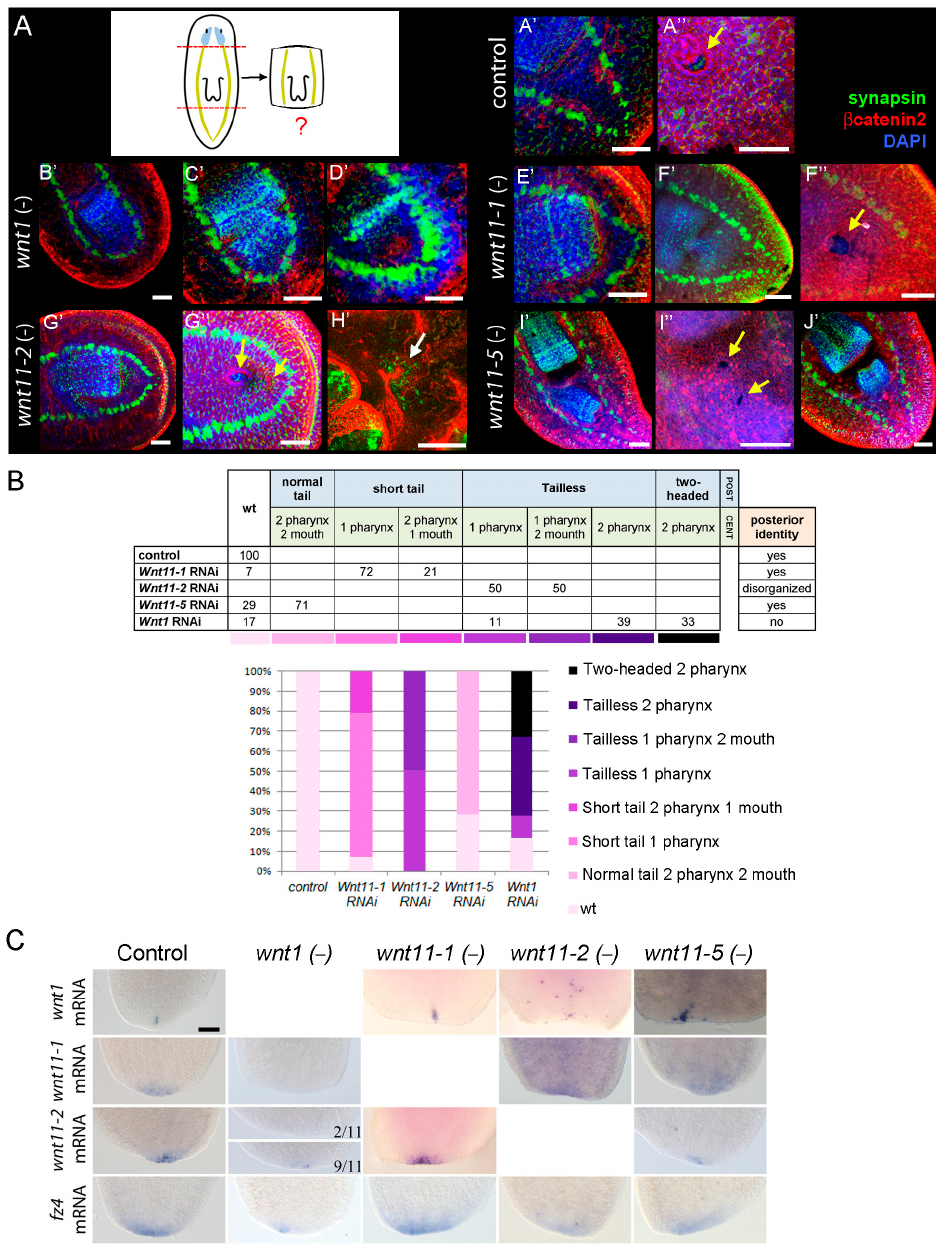
Figure 1. Each posterior wnt exerts a distinct function during planarian posterior regeneration. ( A ) Immunohistochemical analysis of planarian tail after silencing of Smed-wnt1 ( B ′ – D ′ ), Smed-wnt11-1 ( E – F ′′ ), Smed-wnt11-2 ( G ′ – H ′ ) and Smed-wnt11-5 ( I ′ – J ′ ). Anti-synapsin labels the nervous system (green), anti- β catenin1 labels adherent junctions (red), and nuclei are stained with DAPI (4’,6-diamidino-2-phenylindole)(blue). A ′′ , F ′′ , G ′′ and I ′′ show a magnification of the plane corresponding to the mouth opening of A ′ , F ′ , G ′ and I ′ , respectively (mouth openings are indicated with yellow arrows). A primordium of a second pharynx in Smed-wnt11-2 RNAi animals is shown in H ′ (white arrow). Animals were fixed at 20 days of regeneration. All images correspond to confocal z-projections; ( B ) Quantification of the different phenotypes observed after silencing each posterior wnt. (The number of animals analyzed for each condition was at least n = 14.). wt; wild type; ( C ) In situ hybridization analysis of the expression of posterior markers in 3-day regenerating posterior wnt RNAi. (The number of animals analyzed for each condition was at least n = 11.). Anterior is left/up, posterior is right/down in ( A ); anterior is up, posterior is down in C . Scale bar: 100 µm ( A , C ).